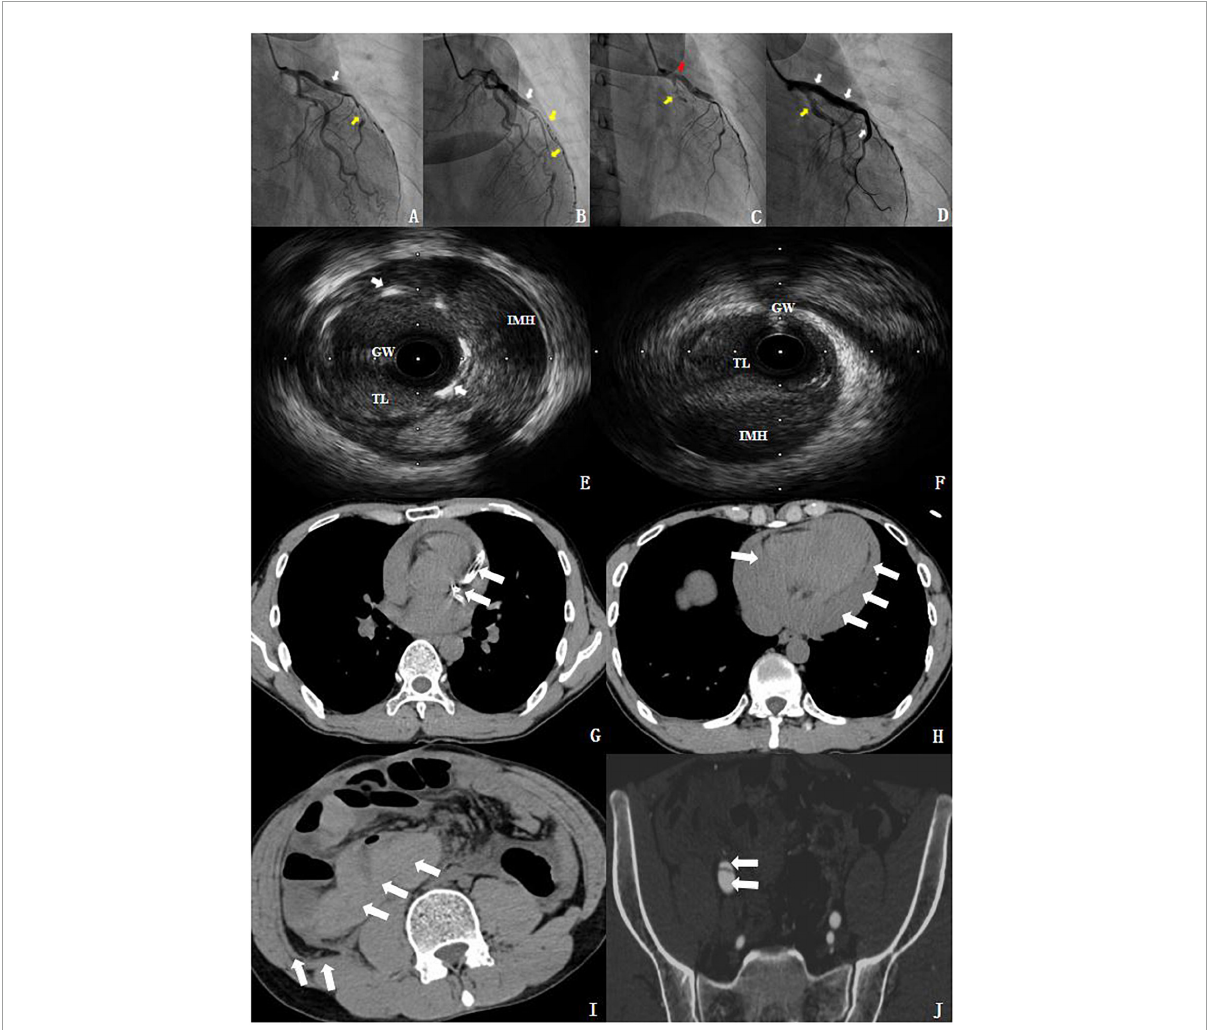
FIGURE3 Imaging findings. (A,B) Coronary angiography (CAG). The white arrow shows a type 1 dissection at the proximal segments of LAD. The yellow arrow indicated a type 2 dissection at the middle segments of the LAD and the diagonal branch. (C) The patient showed progression of coronary artery dissection during the CAG. The red arrow demonstrates that the dissection involved the LM and the yellow arrow indicates a type 4 dissection of the LCX. (D) After revascularization. The white arrow shows the TIMI flow grade 3 at the LM and LAD. The yellow arrow indicates the TIMI flow grade 3 at the LCX. (E) IVUS showed a massive IMH from the media external to the LAD stent; the white arrow indicated the stent struts. (F) The true lumen (TL) of the median LCX segment was severely deformed by the dissection and the massive media layer hematoma. GW, guidewire. (G,H) The chest CT revealed a stent in the left anterior descending coronary artery and hemopericardium. (I,J) The abdominal and pelvic CT showed intestinal wall swelling, hematocele, retroperitoneal hematocele, and an iliac vascular dissection (see section “ Supplementary material